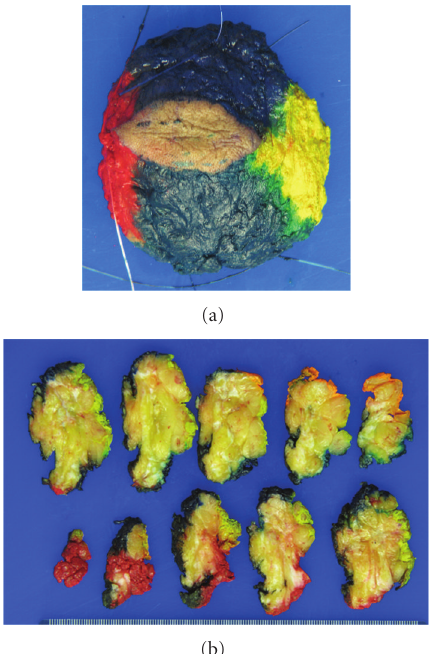
Figure 10: (a) Di ff erent colored inks placed on the surface of a specimen maintain the orientation during sectioning and processing. (b) Serial sectioning of inked specimen showing the di ff erent inks on the edges of the slices.